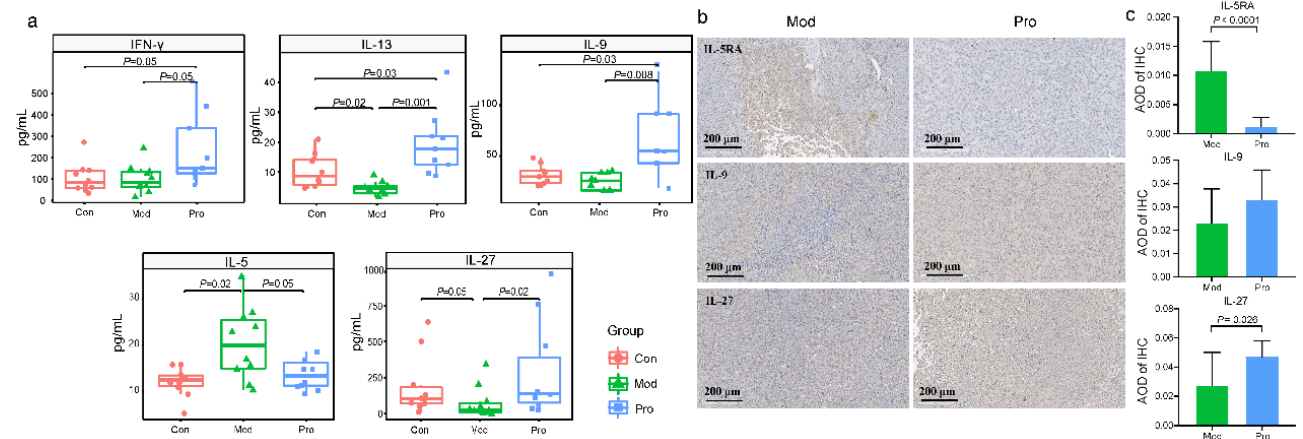
Figure 3. Serum cytokine levels and histochemical staining of cytokines in tumor tissues of the con- trol (Con), model (Mod), and probiotic (Pro) groups at day 22. ( a ) Differences in serum concentrations of interferon- γ (IFN- γ ), interleukin (IL)-13, IL-9, IL-5, and IL-27 between groups were evaluated using Wilcoxon tests. ( b ) Immunohistochemistry (IHC) of IL-5RA, IL-9, and IL-27 of representative sections of tumor tissues of Mod and Pro groups, 25× magnification (scale bar represents 200 µ m). ( c ) the average optical density (AOD) of IHC between Mod and Pro groups were evaluated using Wilcoxon tests.